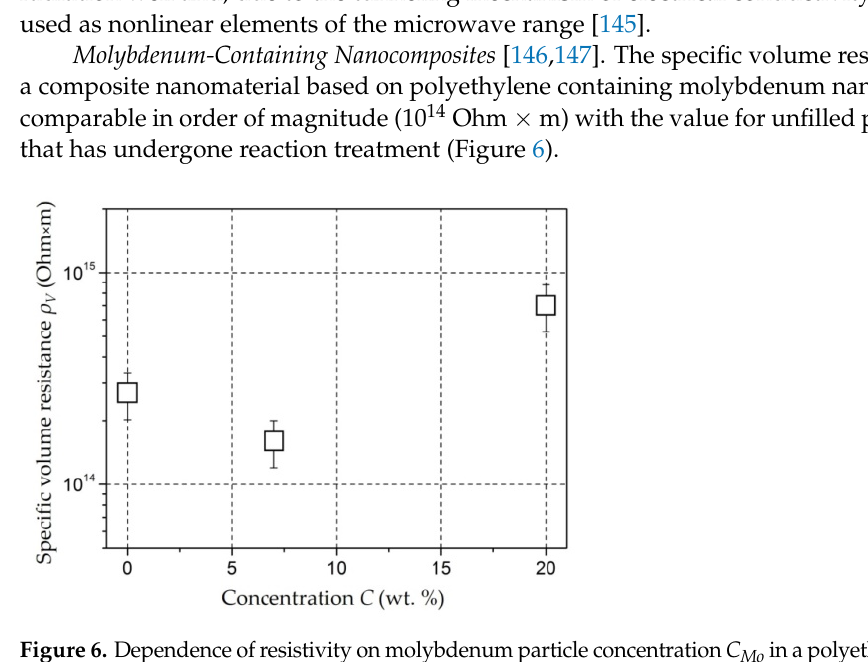
Figure 6. Dependence of resistivity on molybdenum particle concentration C Mo in a polyethylene matrix.